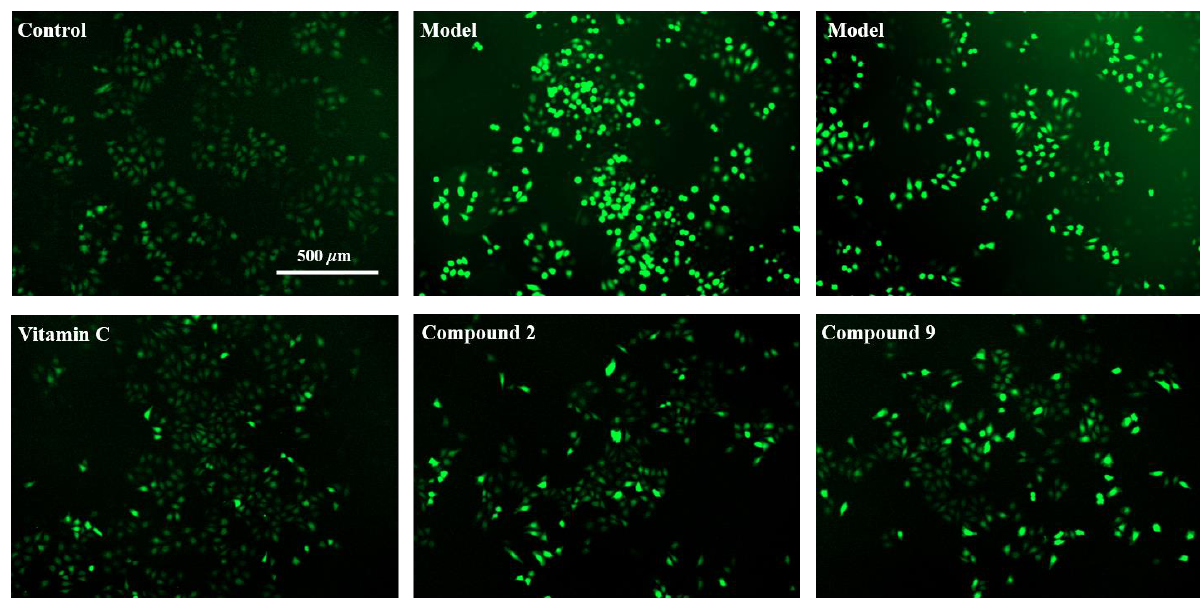
Figure 10. ROS production of compounds 2 and 9 at 5 µM on H 2 O 2 -induced injury in L02 cells showed in fluorescence images. Vitamin C was used as positive control (5 µM). Photographed by cell imaging multi-mode reader (Cytation 1, BioTek) at 4×, scale bar: 500 µm.